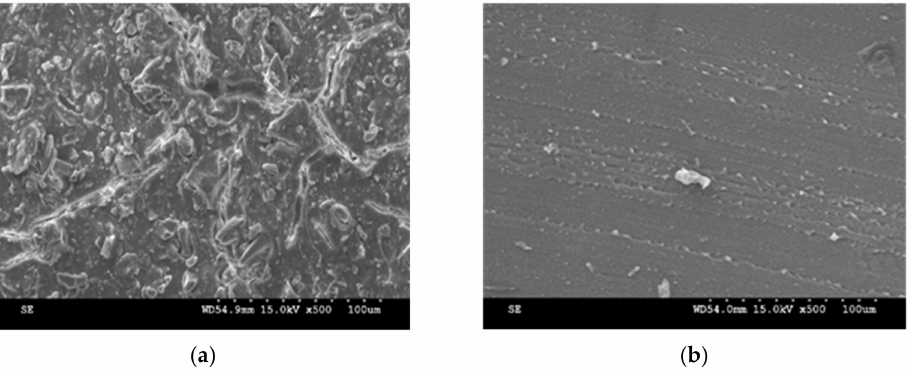
Figure 7. ( a ) Scanning electron microscopy (SEM) images for the TGA residue for the SiR + 30 wt% GS10 and ( b ) TGA residue for the SiR + 5 wt% FS07 under an N 2